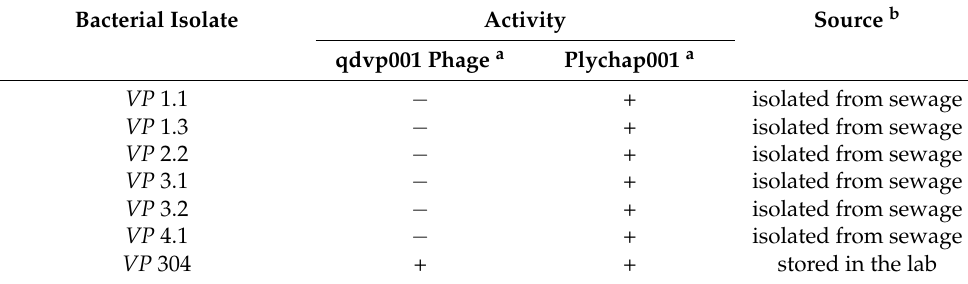
Table 2. Antibacterial spectra of Lysqdvp001 phage and recombinant